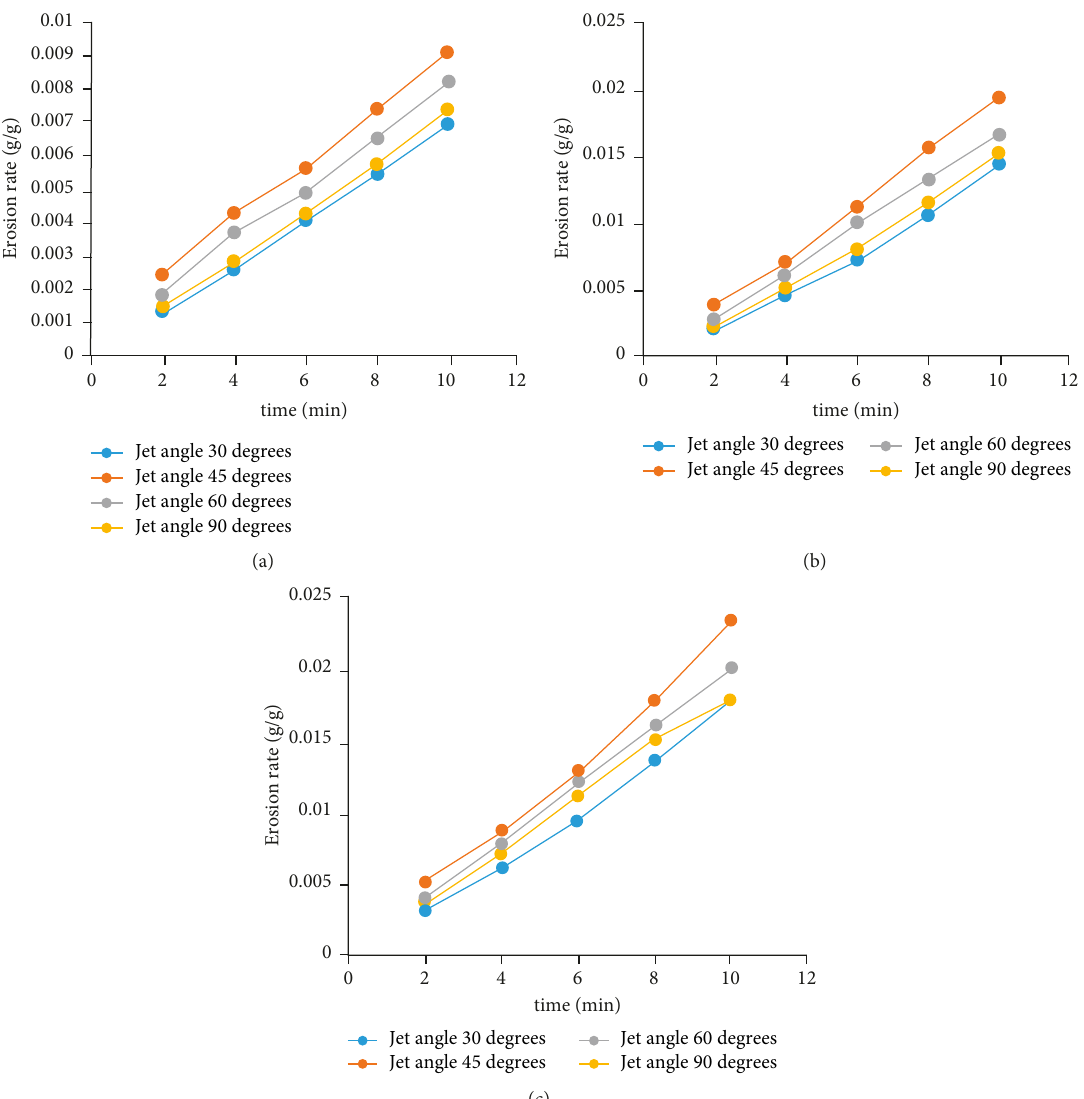
Figure 7: 5 layers glass fibre. (a) 1 bar pressure and 2.5% nanocarbon powder filler. (b) 1.5 bar pressure and 2.5% nanocarbon powder filler. (c) 2 bar pressure and 2.5% nanocarbon powder